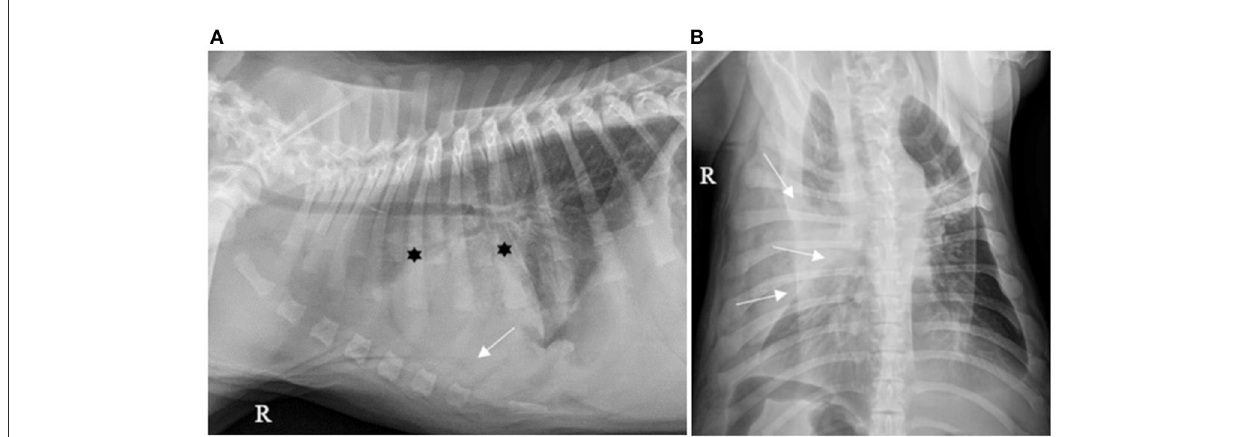
FIGURE3 (A) Right lateral and (B) ventro-dorsal thoracic X-rays of a dog with AP associated with severe PE. An alveolar pattern is mainly distributed cranioventrally in the right cranial and middle lobes (*). PE is identified by thick pleural fissure lines associated with border effacement by a fluid opacity band, ventral to the cardiac and diaphragmatic silhouettes and lateral to the right chest wall, pushing the lung lobes medially (white arrows). AP, aspiration pneumonia; PE, pleural effusion (source: medical imaging department of the veterinary university clinic of Liege, Belgium).